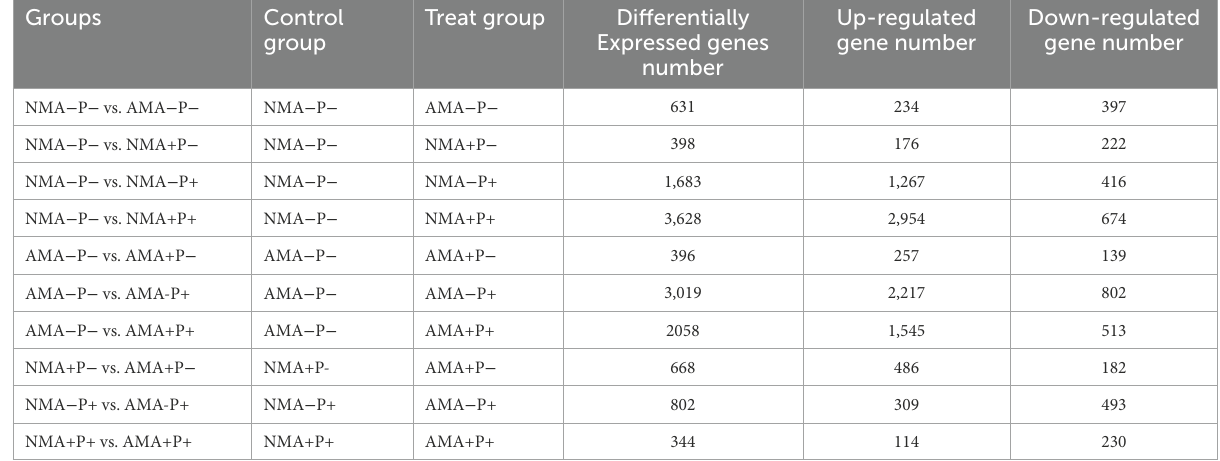
TABLE 2 Counts of differentially expressed genes in alfalfa with AM fungus, aphids and pathogen treatments. Groups